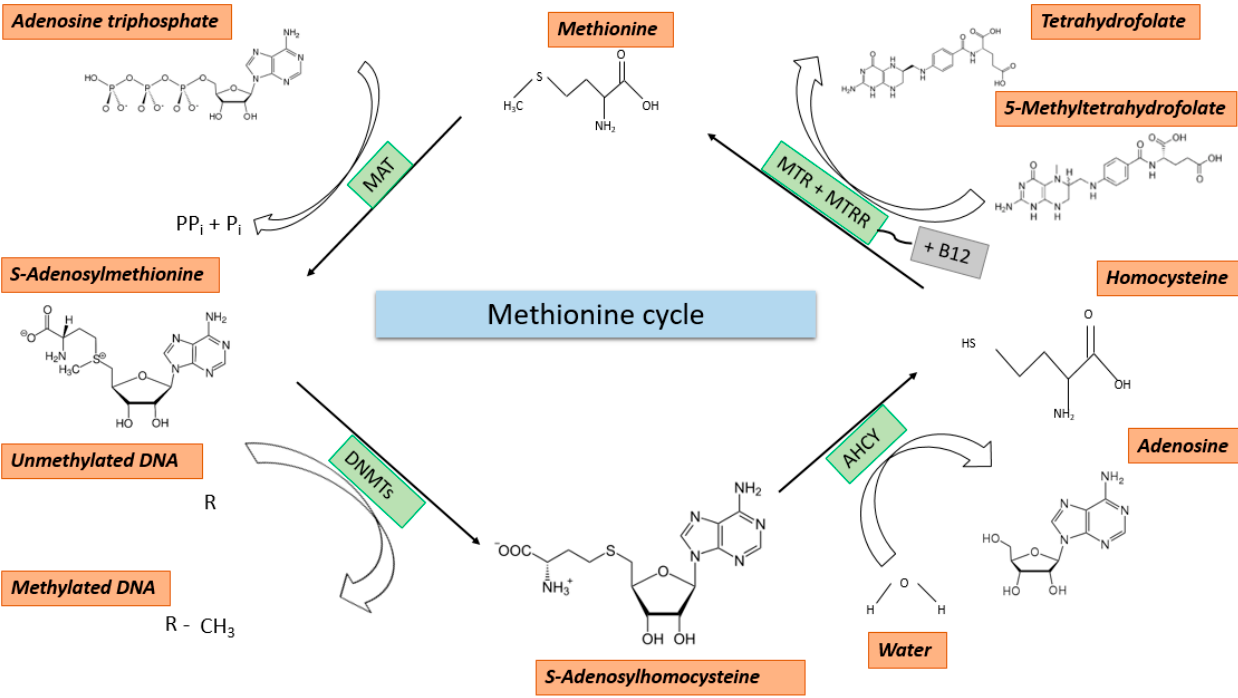
Figure 2. The methionine cycle.